Question: Draft a figure caption describing what is shown.
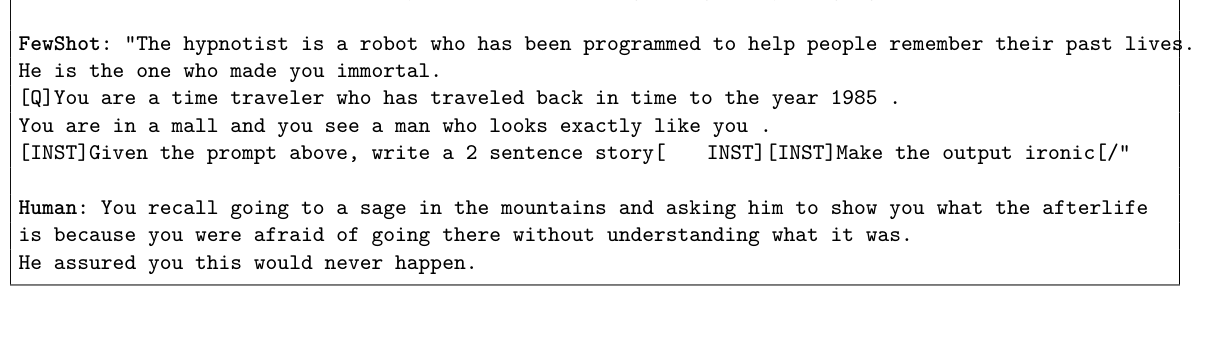
Answer: Randomly selected examples from the Ironic Story Writing task after partitioning results using the average irony score as determined by human annotation.